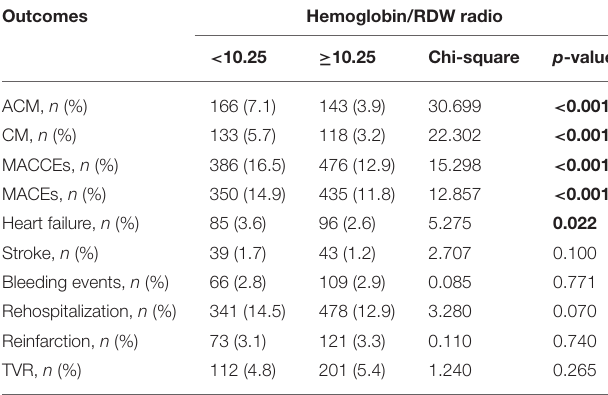
TABLE 2 | Outcomes comparison two